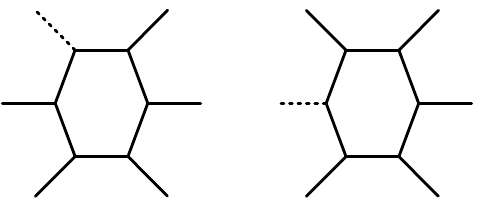
Figure 4. Two forms of one leg failure of a hexapod robot.